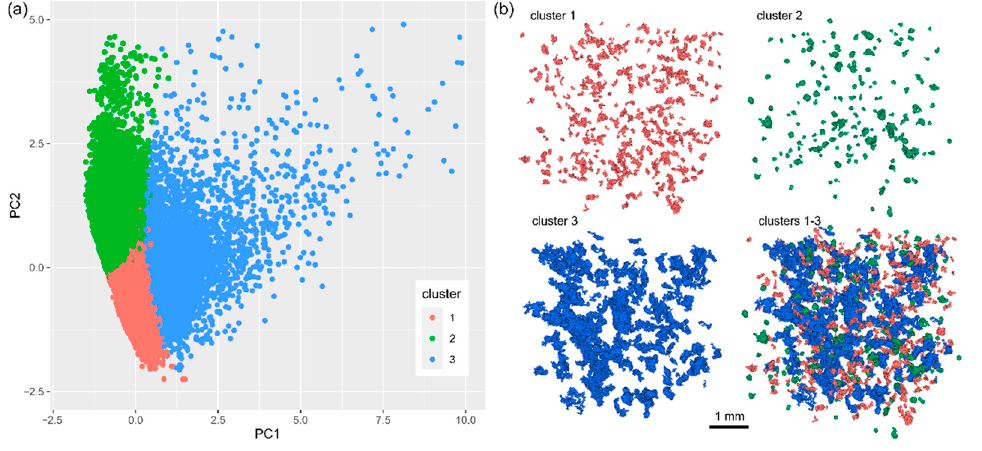
Figure 9. ( a ) Results of the cluster analysis: data classification in the PC coordinate system and ( b ) visual representation of the clustering results presented as a fragment of the VOI.